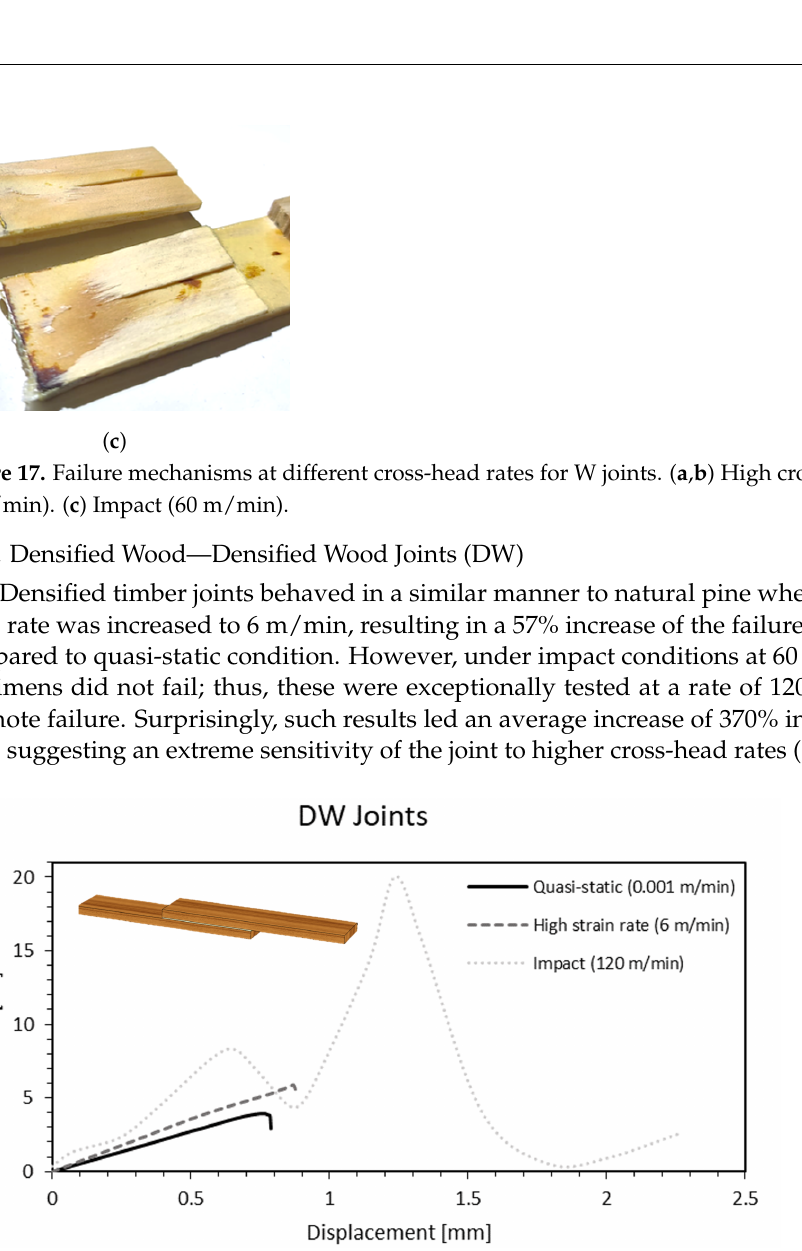
Figure 18. Load-displacement curve of a W joint as a function of the cross-head